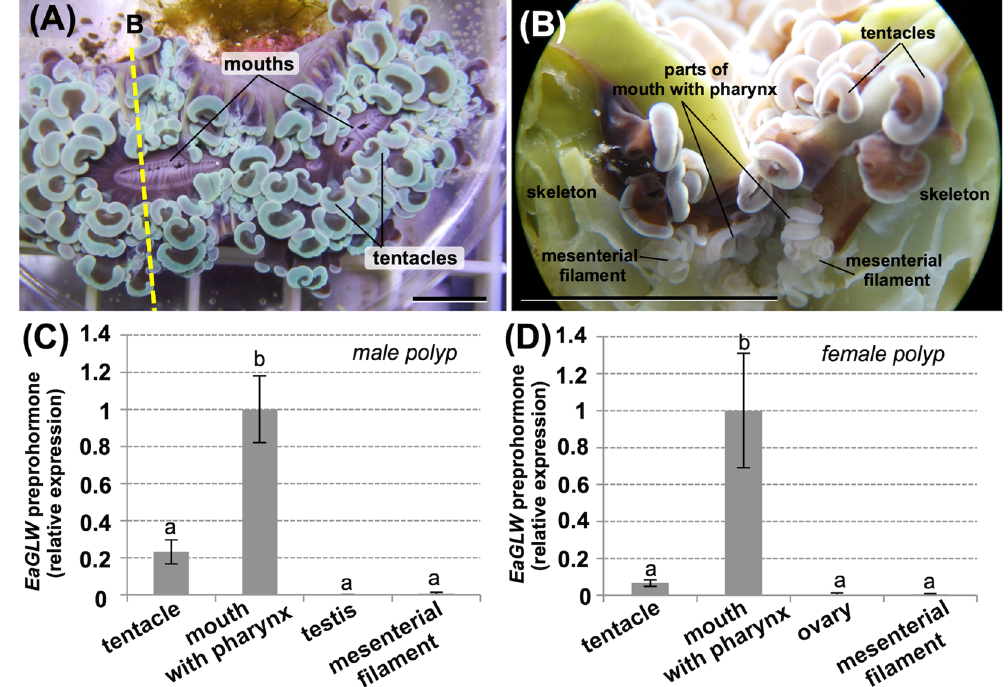
Figure 3. ( A ) Representative picture of E. ancora in an aquarium (viewed from above). Mouths are at the middle of the polyps, and tentacles surround the mouths. Bar, 1 cm. ( B ) Representative picture of a polyp, including the skeleton, dissected through the mouth at the position of the yellow-broken line shown in (A). Bar, 1 cm. ( C ) Expression levels of EaGLW preprohormone transcripts in different types of male polyp tissues. ( D ) Expression levels of EaGLW preprohormone transcripts in different types of female polyp tissues. For this analysis, 4 different parts of polyp tissues (the tentacle, mouth including pharynx, gonad, and mesenterial filament) were microscopically isolated, and the expression levels of the EaGLW preprohormone transcripts were investigated by quantitative RT-PCR analysis. Data are shown as the mean ± SE (4 male or 3 female colonies) of the relative values of the mouth group. E. ancora β -actin was used as the reference gene. Groups with different letters are significantly different (P <